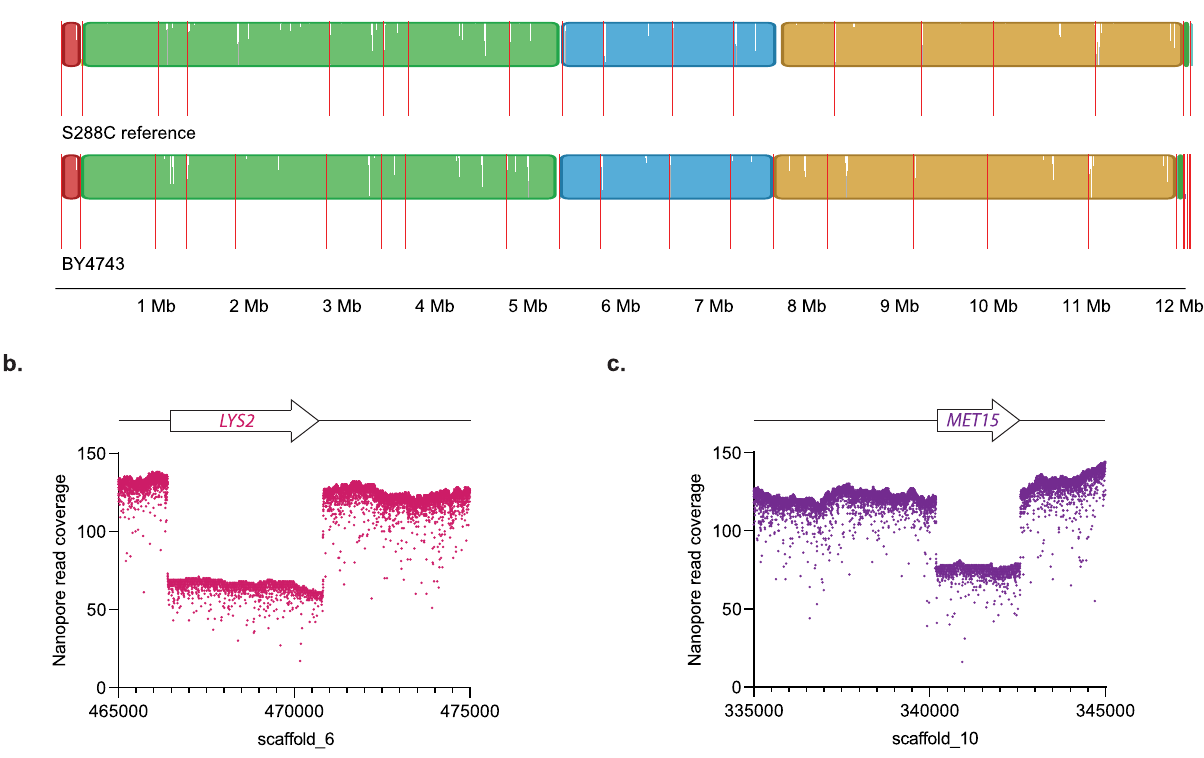
Fig. 4 Genome assembly analysis of the heterozygous diploid S. cerevisiae strain BY4743. a Mauve genome alignment between the S. cerevisiae S288C reference assembly and the S. cerevisiae BY4743 genome assembly. The colored blocks represent regions of the genomes that align, while the vertical red lines indicate a new contig. b Nanopore read coverage around the heterozygous LYS2 gene. c Nanopore read coverage around the heterozygous MET15